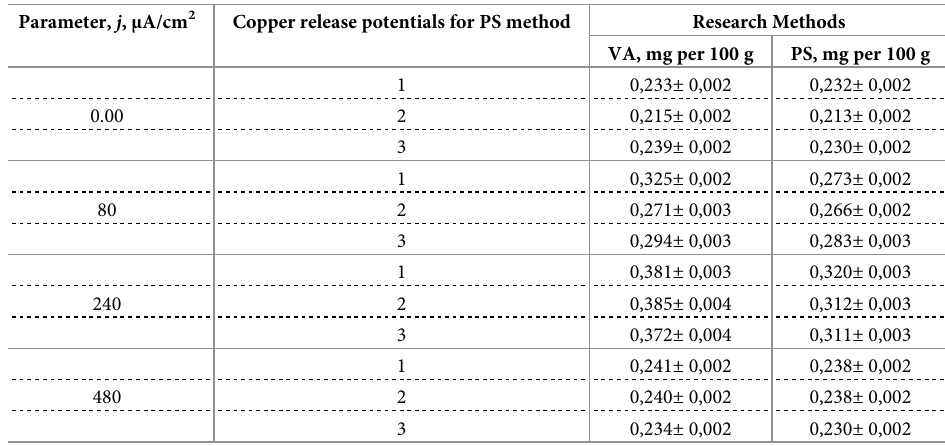
Table 3. Comparative results of VA and PS